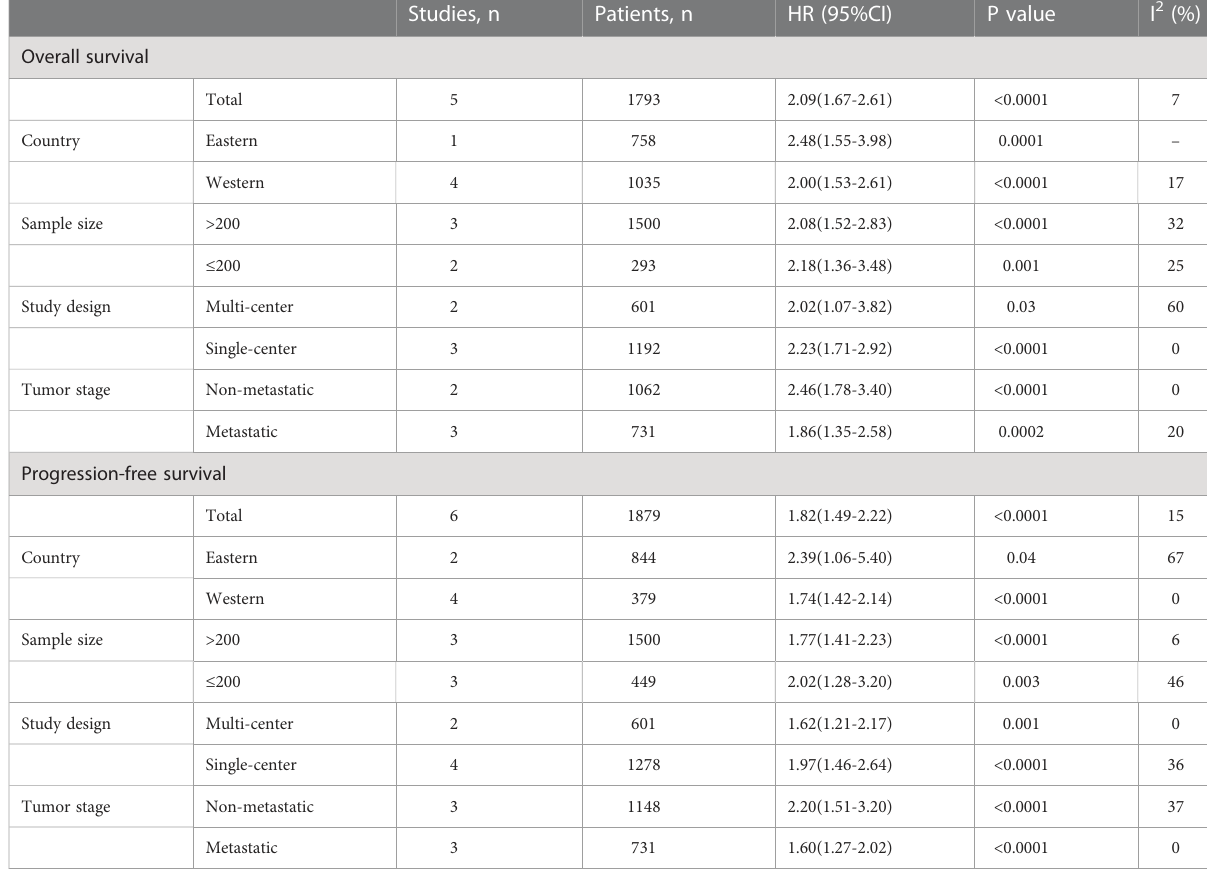
TABLE 3 Subgroup analyses for OS and PFS of PIV-high patients vs. PIV-low patients.